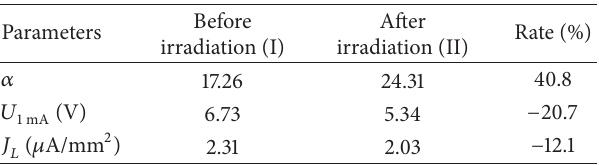
Table 1: Electrical properties of films before and after laser- irradiation